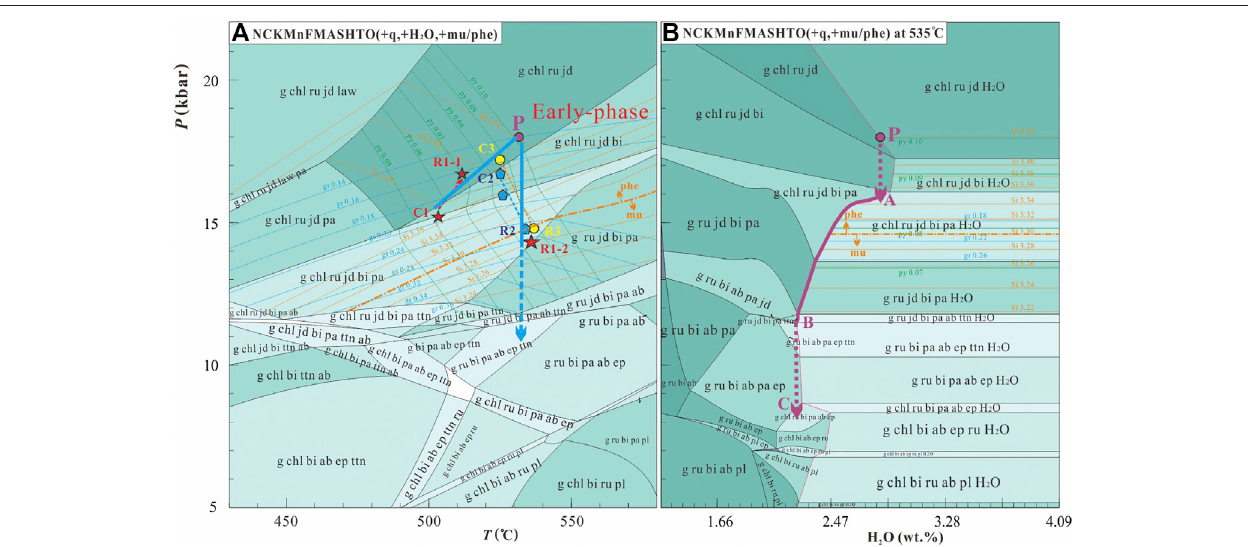
FIGURE6|(A) P – T pseudosectionforsampleEL01calculatedinthesystemNCKMnFMASHTO(+q,H 2 O,mu/phe)usingthemodi fi edbulk-rockcompositionfrom Table 1, and (B) P-M(H 2 O) pseudosection calculated at temperature of 535 ° C. The pseudosections show isopleths of py (pyrope) and gr (grossular) in garnet and Si content in phengite for relevant mineral assemblages. The plots of the measured pyrope and grossular in the core and rim of different garnet grains (g01, g02, and g03) are shown as different shapes marked with C (C1, C2, and C3) and R (R1, R2, and R3). The R1-1 and R1-2 represent right and left rim of the grain g01. Mineral abbreviations: law, lawsonite; ctd, chloritoid; o, omphacite; jd, jadeite, pl, plagioclase others are the same as in Figure 3 .